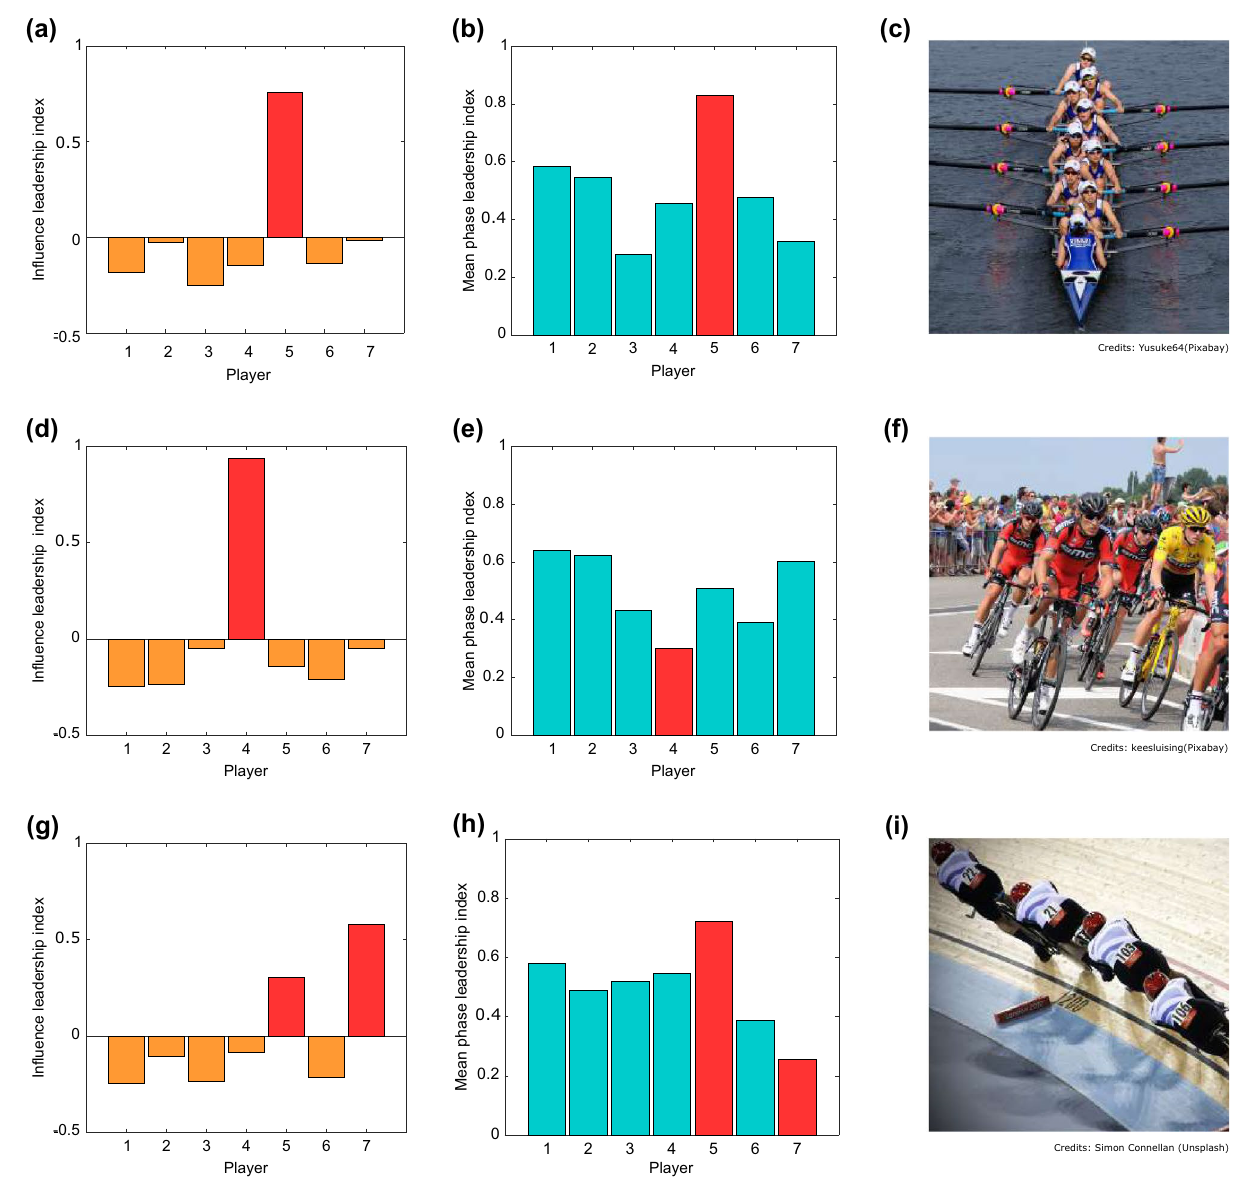
Figure 2. Description of the leadership scenarios. In the first column, each bar represents the value of the influence leadership index (see “Methods”). The central column shows the mean phase leadership index for each player. The red bars identify the relationship between these two metrics typical of each pattern (Pattern 1- top row, Pattern 2- middle row, Pattern 3- bottom row). The third column displays an example for each leadership scenario from sports world. In particular, ( c ) reports an example of the first scenario, where the role of a coxswain is to steer the boat and coordinate the rhythm of the team members. ( f ) Depicts professional road cyclists racing at the Tour de France . It is a paradigmatic example of leadership assigned to the participant lagging behind all the others, since the team leader typically drafts the wheels of her/his teammates (domestiques) but is pivotal for determining the team strategy. ( i ) An example of shared leadership observed during team pursuit in track cycling, where the fastest player in front sets the pace, but also accounts for the position of the third lagging player, since the final time for the team is taken when the third team member crosses the finish line. Images are taken from https:// pixab ay. com and https:// unspl ash.